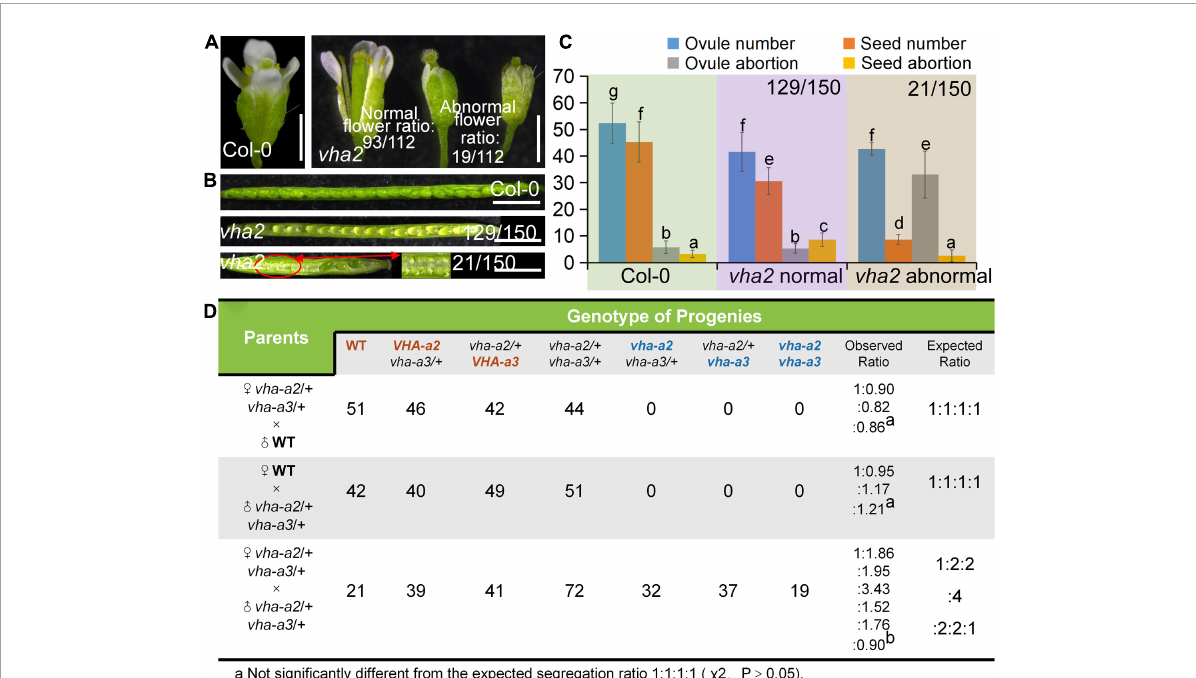
FIGURE1 Lack of V-ATPase results in abnormal embryonic development. (A) Flower development at stage-13 in Col-0 and vha2. Statistics on the ratio of normal and abnormal microspores in vha2 are shown in each image. Bar = 1 mm. (B) Seed development in Col-0 and vha2. Two types of siliques of vha2 correspond to those in (A) . (C) Statistics analysis of ovule number, seed number, ovule abortion, and seed abortion in Col-0 and vha2. Bars represent the mean ± SD of three biological replicates ( n =30). Lowercase letters indicate statistically significant differences between different stages ( P < 0.05). Theoretically, ovule number = seed number + ovule abortion + seed abortion. (D) Both male and female transmission of vha-a2, and vha-a3 are comparable to VHA-a2 and VHA-a3 of WT. Genotypes consistent with wild type are marked in red font, homozygous mutant genotypes are marked in blue font, and heterozygous mutant genotypes are marked in black